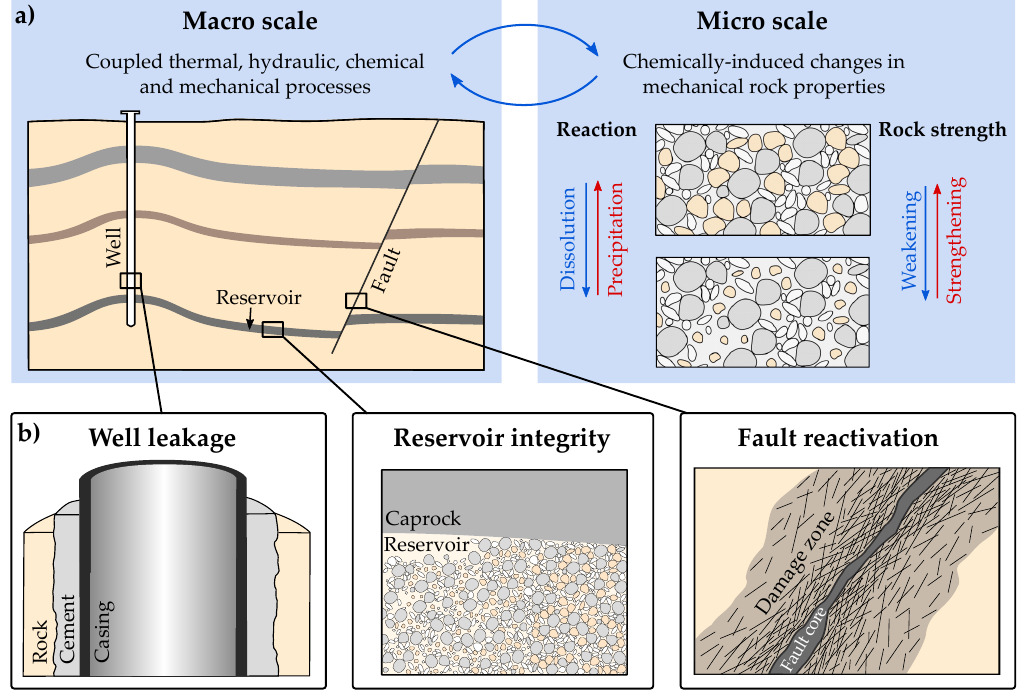
Figure 1. ( a ) Chemical processes at micro scale, as the precipitation and the dissolution of minerals, can significantly weaken or strengthen a rock, which affects coupled processes at the macro